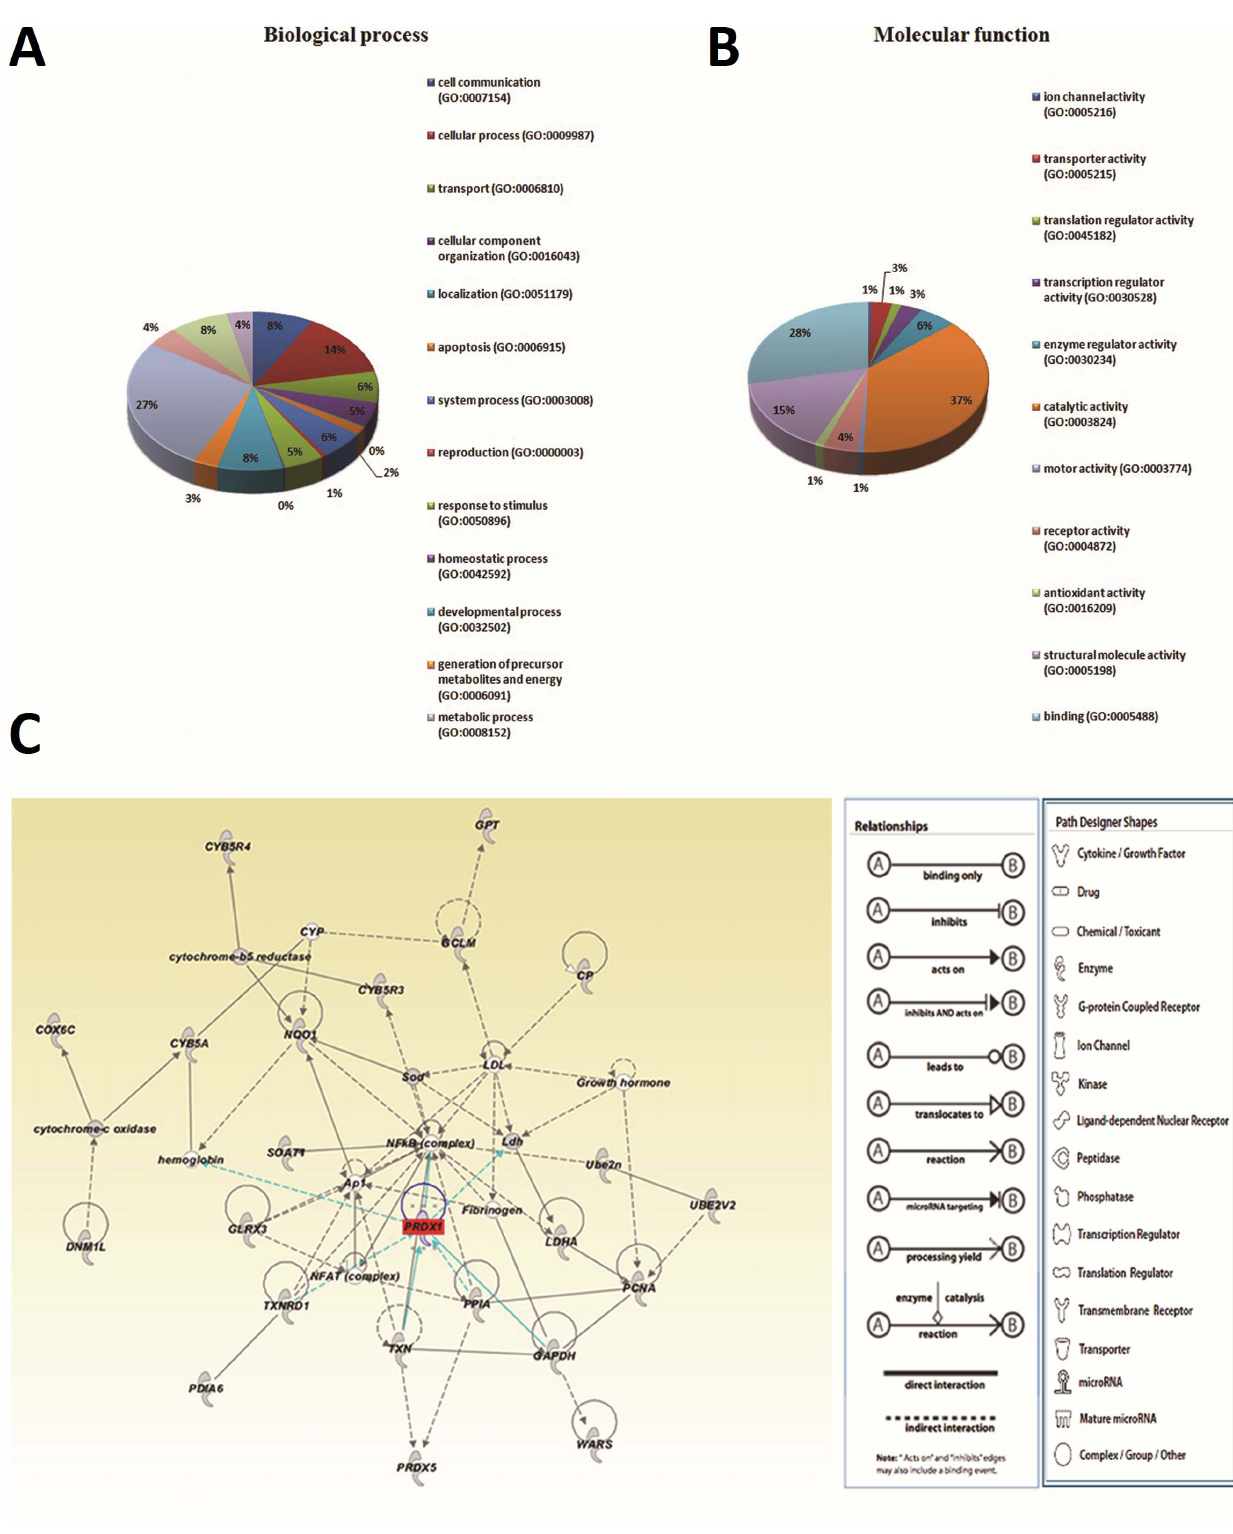
Figure 2. Bioinformatic analysis of differentially expressed proteins after treatment with BI-TK/GCV. PANTHER classification of proteins based on (A) Biological process and (B) molecular function. (C) Interplaying network of proteins with abundance change generated by Ingenuity pathway analysis (IPA). The network implied the connection of Prx-I and NF- k B complex.